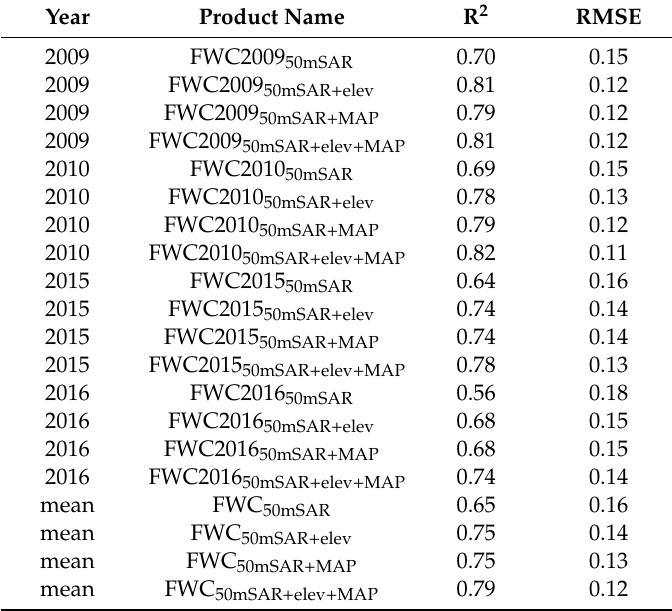
Table 1. Model uncertainty of fractional woody cover estimates at 50 m resolution by various FWC products for di ff erent years, including elevation (elev) and / or MAP as ancillary variables. R 2 = coe ffi cient of determination, RMSE = Root mean square error, N = 75,828.